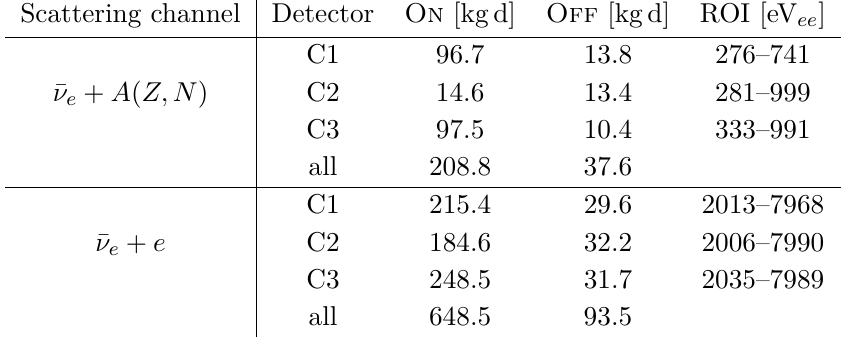
Table 2 . Lifetimes for reactor On and Off periods together with the regions of interest (ROIs) for the different detectors in both scattering channels during Run -1, specifying the data sets that are investigated for BSM signatures in this